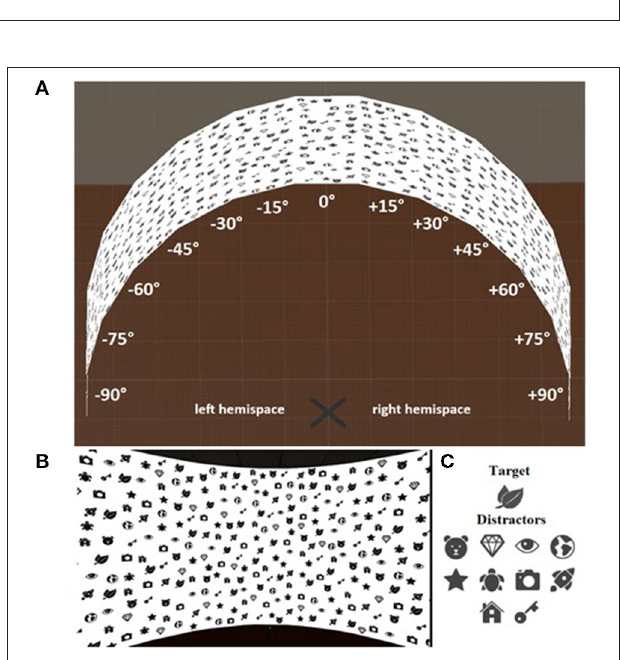
FIGURE 1 | (A) Bells Test and (B) its target distribution (Gauthier et al., 1989).